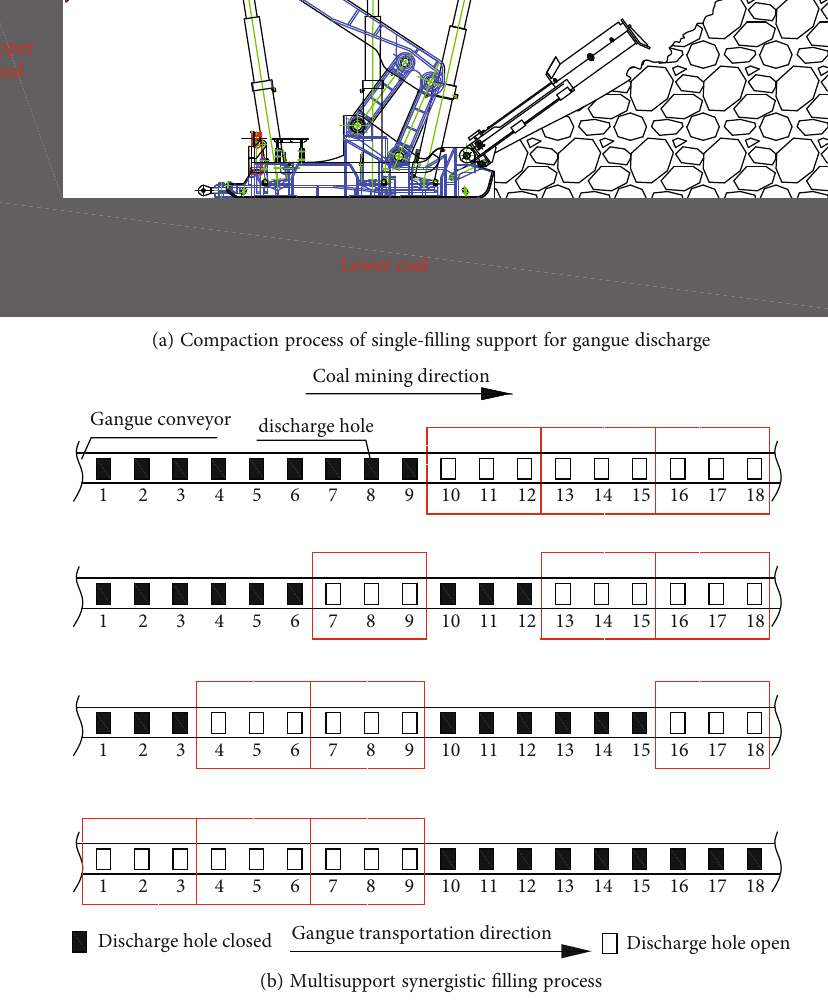
Figure 12: Coal mining fi lling parallel and group fi lling